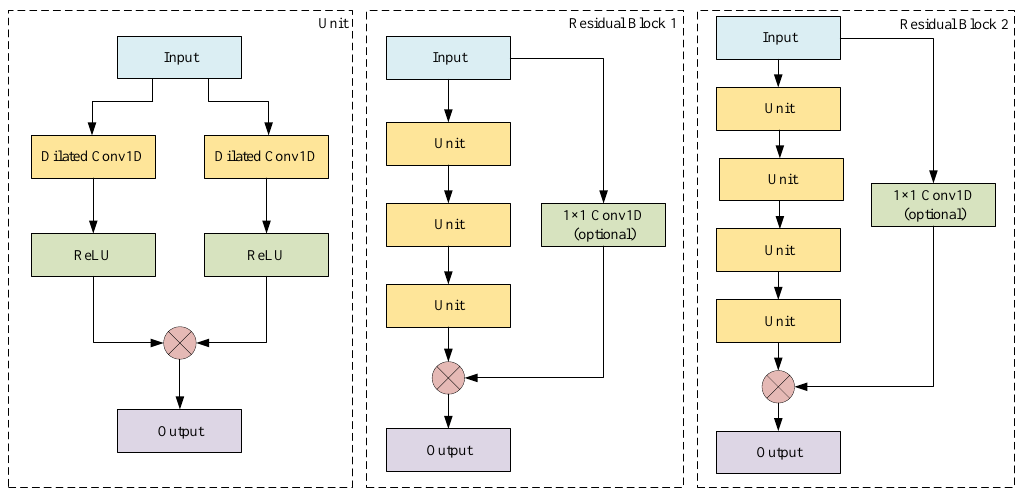
Figure 5. Residual Block in our network. ( left ) details of the Unit architecture. ( middle ) Residual Block 1; ( right ) Residual Block